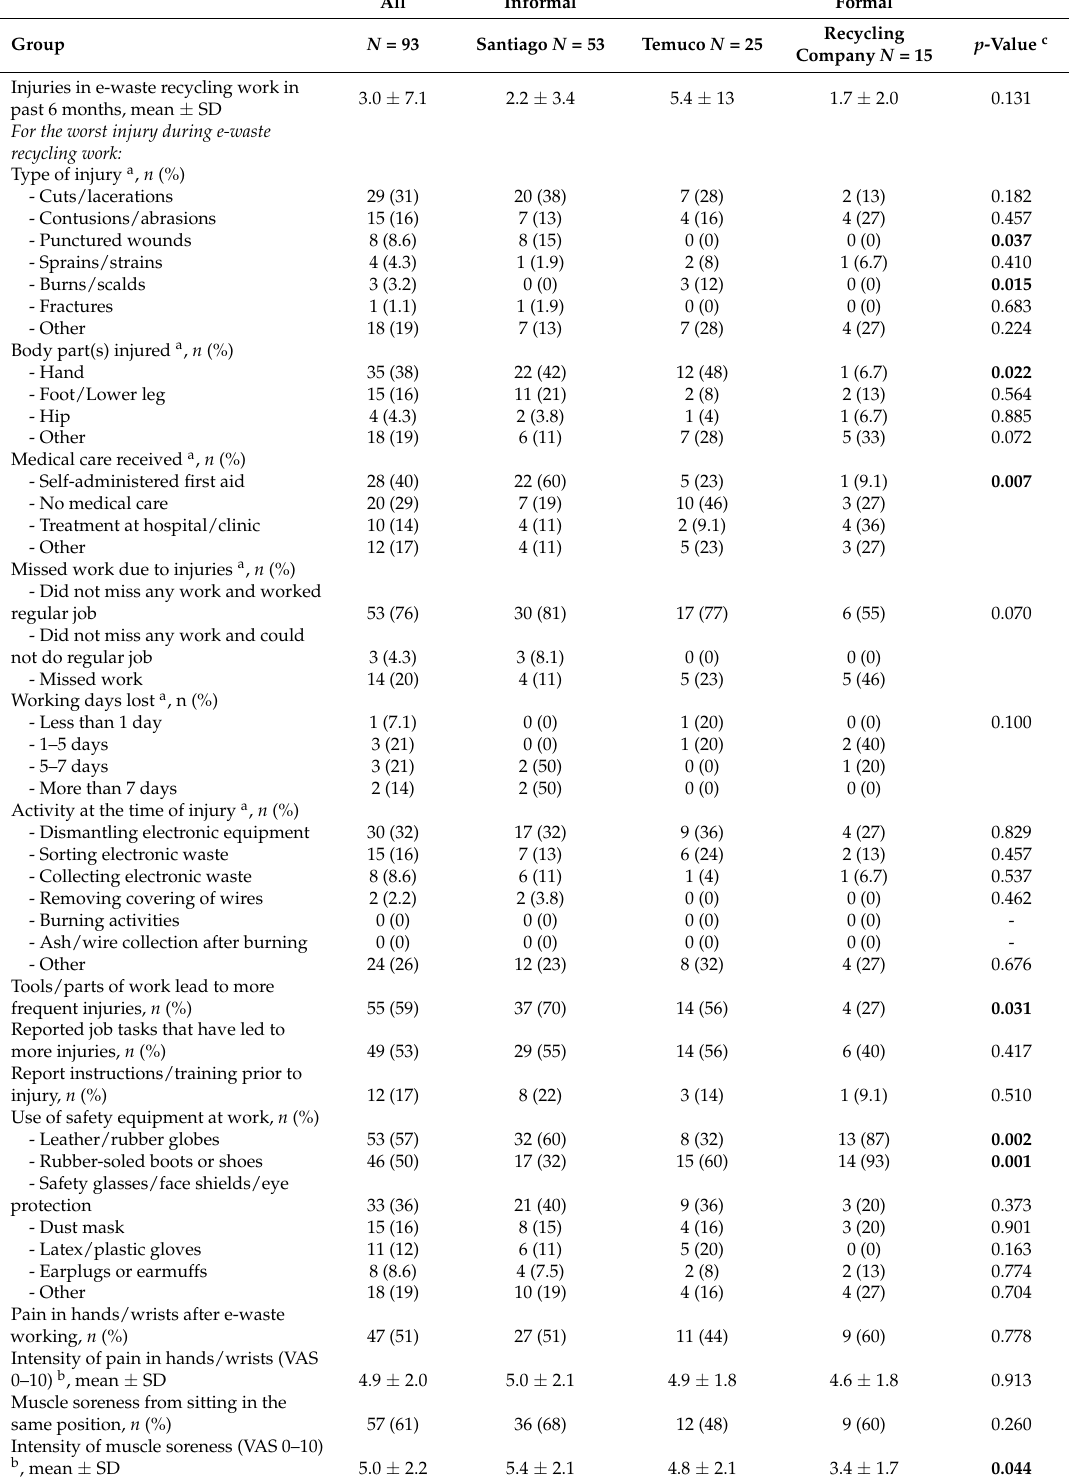
Table 7. Self-report injuries in the study population, by job type and